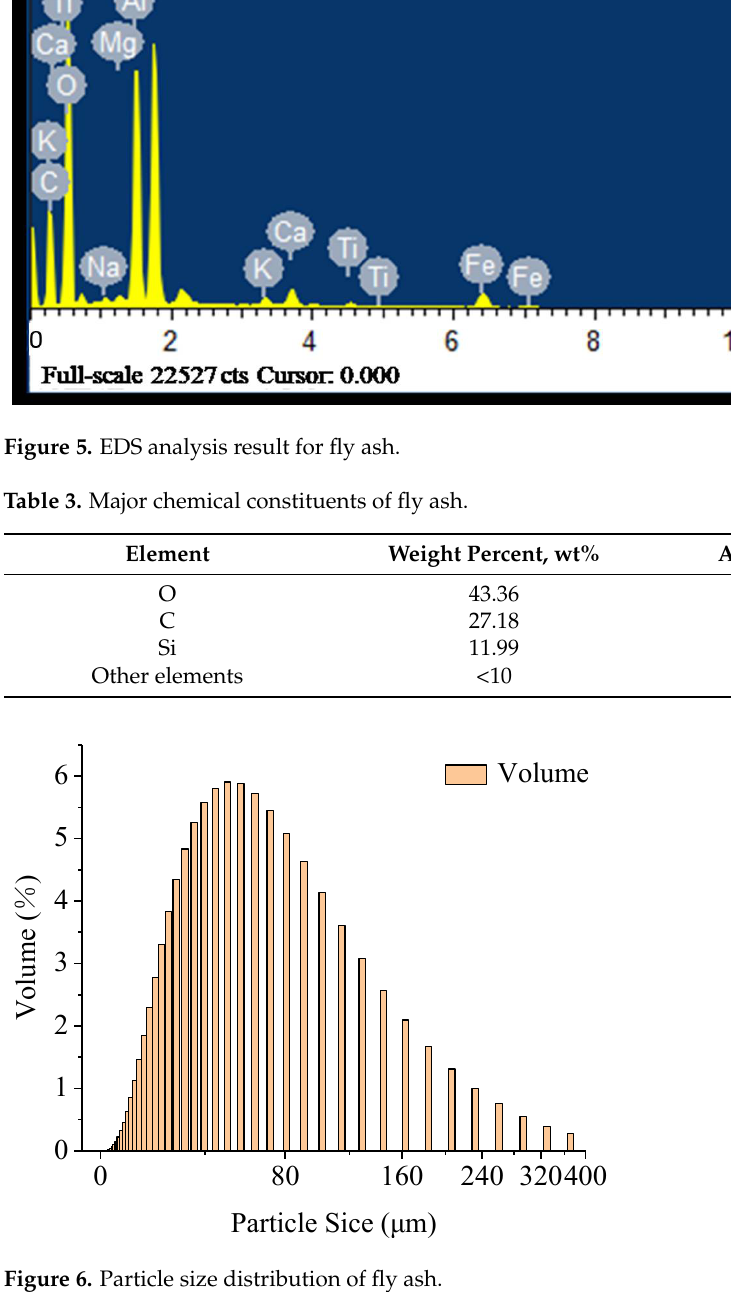
Figure 6. Particle size distribution of fly ash. Table 3. Major chemical constituents of fly ash.